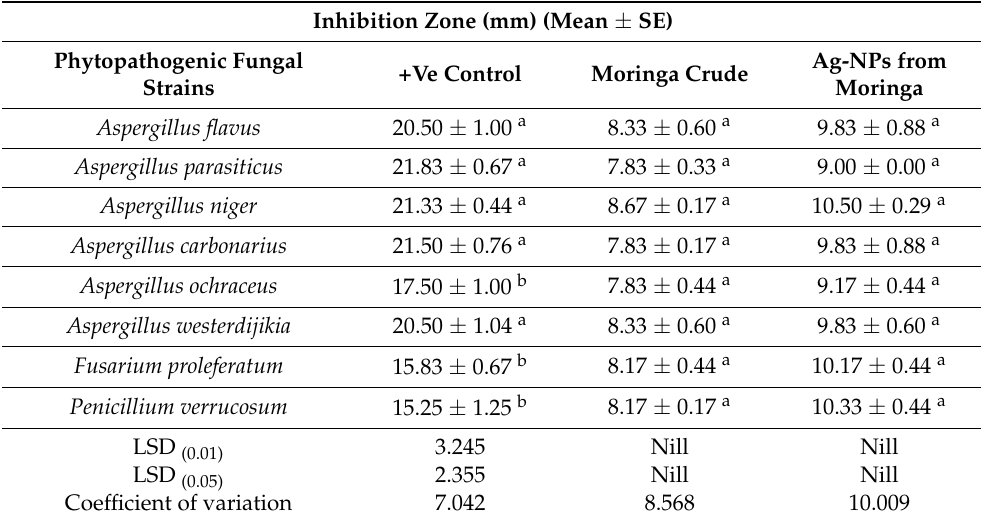
Table 9. Antifungal activity of Moringa crude aqueous extracts and synthesized Ag-NPs against different fungal strains by disc diffusion